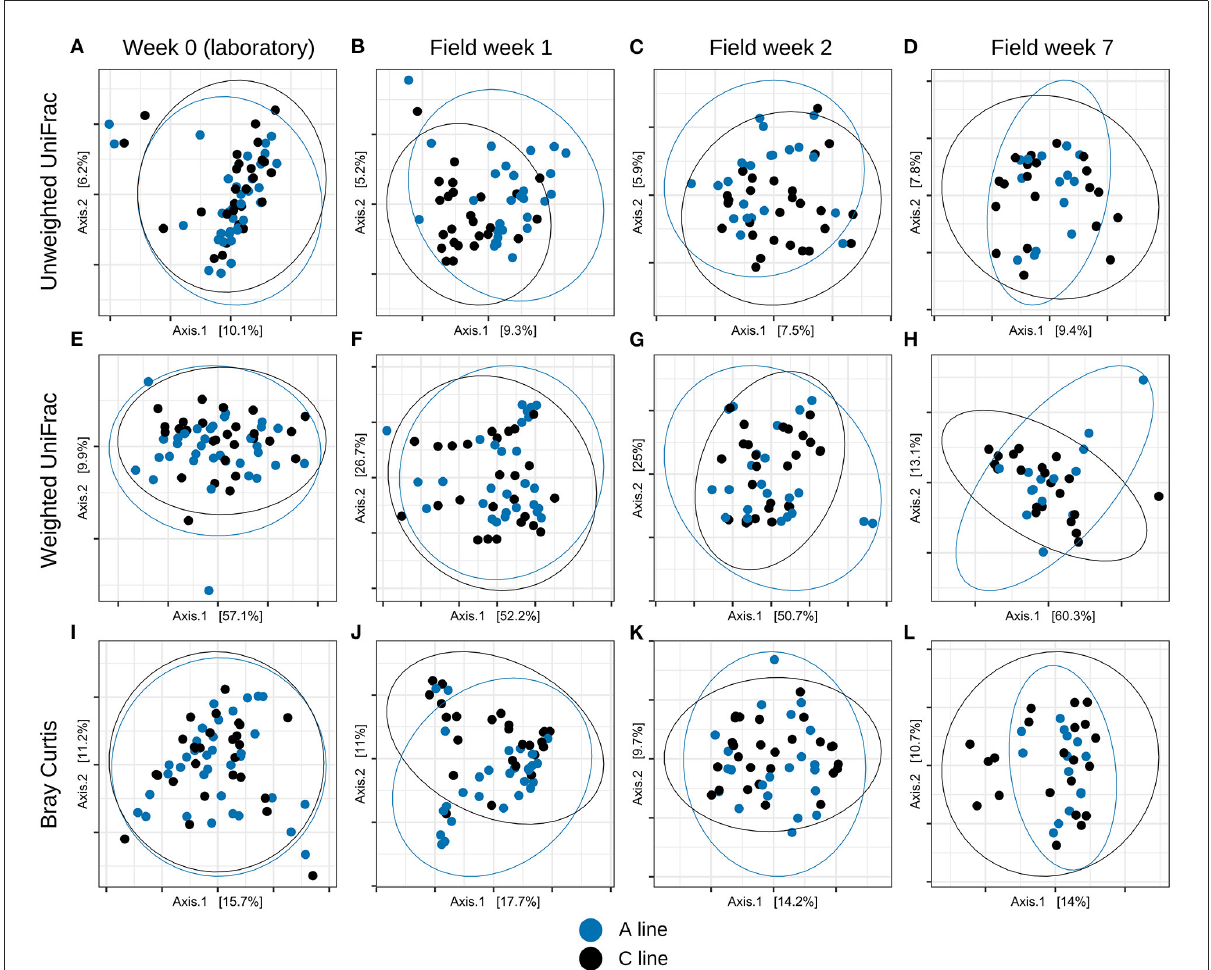
FIGURE4 PCoA plots of bacterial community composition displaying the longitudinal change in the bank vole gut microbiotas throughout the experiment for (A–D) Unweighted UniFrac, (E–H) Weighted UniFrac and (I–L) Bray–Curtis dissimilarity. Dots represent individual samples (A line, blue; C line, black), ellipses indicate 95% confidence